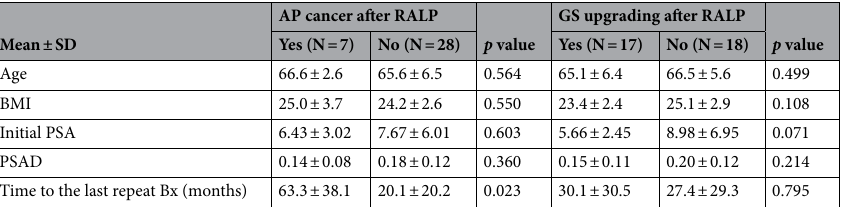
Table 2. Comparative analysis between groups after radical prostatectomy. AP adverse pathology, RP radical prostatectomy, SD standard deviation, RALP robot-assisted laparoscopic radical prostatectomy, BMI body mass index, PSA prostate specific antigen (ng/mL), PSAD prostate specific antigen density (ng/mL/cc), Bx prostate biopsy.